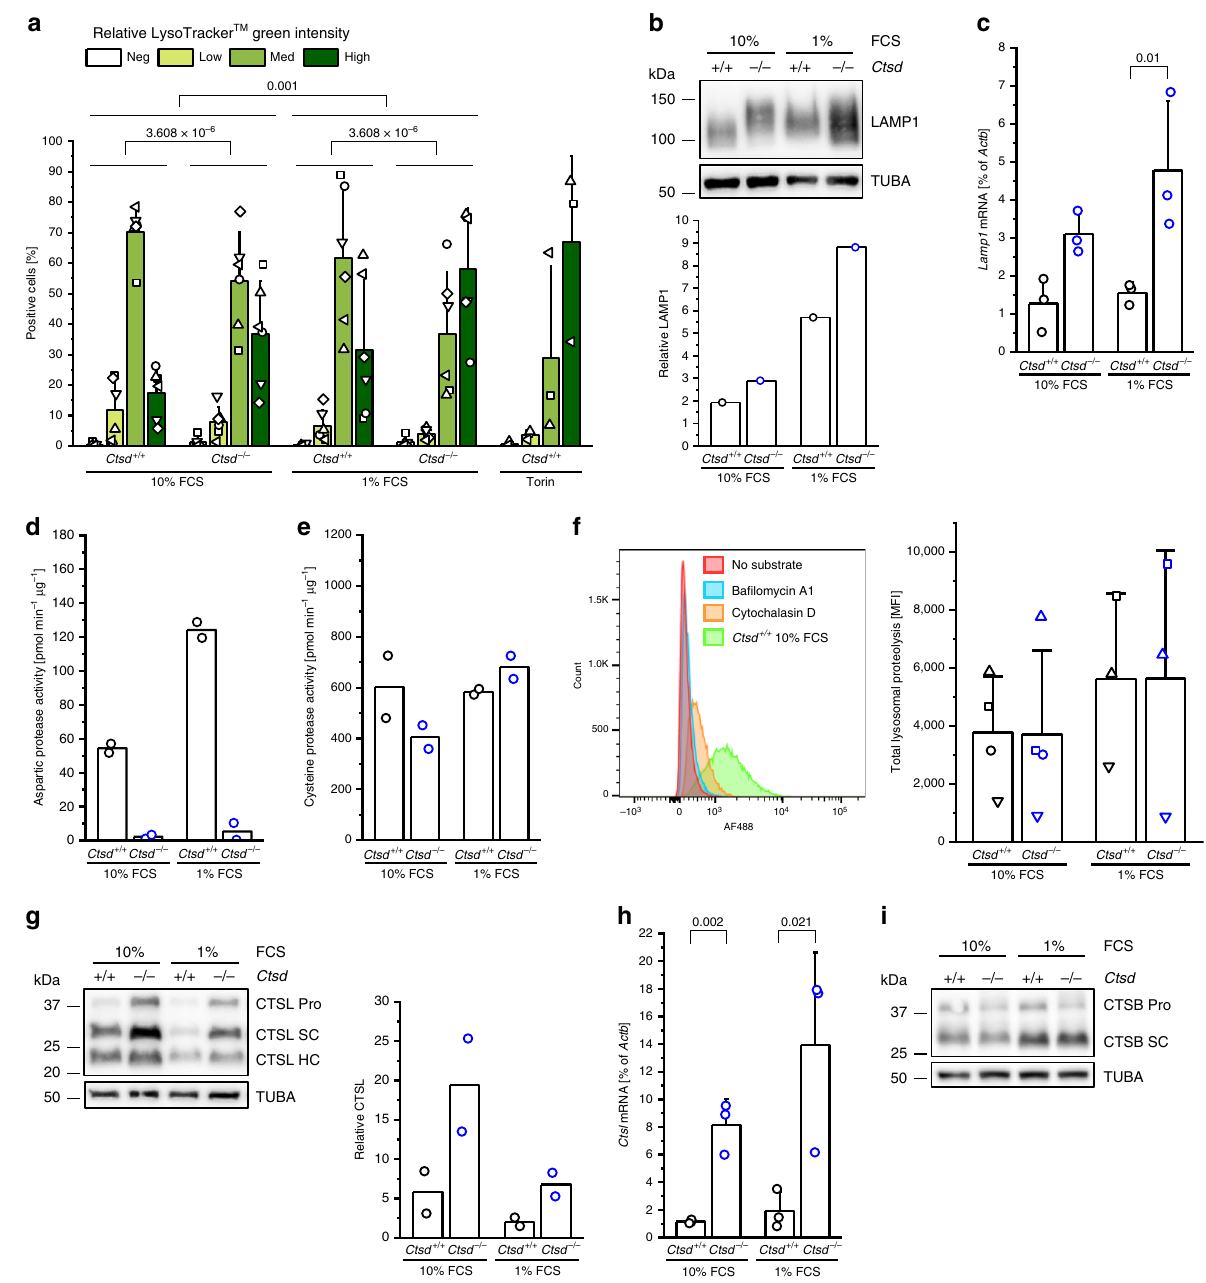
Fig. 4 CTSD de fi ciency expands the acidic cell compartment of short-term starved tumor cells. a Flow cytometry analysis of LysoTracker TM Green intensity in Ctsd + / + and Ctsd − / − PyMT cells cultured for 7 – 10 days in 10% FCS or 1% FCS medium or treated with Torin ( n = 3 independent experiments for Torin, n = 6 independent experiments for the rest; two-sided three-way ANOVA for the factors intensity of LysoTracker TM , Ctsd genotype and FCS). b Analysis of LAMP1 expression by Western blot (with TUBA as loading control) in 10% FCS and 1% FCS Ctsd + / + and Ctsd − / − PyMT cells. Slight molecular weight changes due to different glycosylation pattern. Representative of 2 independent experiments. Quanti fi cation is below ( n = 1 experiment). c Relative Lamp1 expression determined by RT-PCR in 10% FCS and 1% FCS Ctsd + / + and Ctsd − / − PyMT cells ( n = 3 independent experiments; two-sided two-sample t -test). Activity assay with substrates speci fi c for aspartic ( d ) or cysteine ( e ) proteases in 10% FCS and 1% FCS Ctsd + / + and Ctsd − / − PyMT cells ( n = 2 independent experiments). f Lysosomal activity assay using a quenched fl uorogenic substrate in 10% FCS and 1% FCS Ctsd + / + and Ctsd − / − PyMT cells ( n = 4 independent experiments for 10% FCS, n = 3 independent experiments for 1% FCS). Histogram including controls blocking the endocytic substrate uptake (Cytochalasin D) or lysosomal acidi fi cation (Ba fi lomycin A1) on the left, median fl uorescence intensity (MFI) on the right. g Analysis of CTSL expression by Western blot (with TUBA as loading control) in 10% FCS and 1% FCS Ctsd + / + and Ctsd -/- PyMT cells. Pro, zymogen; SC, single-chain form; HC, heavy chain. Representative of 2 independent experiments. Quanti fi cation is to the right ( n = 2 independent experiments). h Relative Ctsl expression determined by RT-PCR in 10% FCS and 1% FCS Ctsd + / + and Ctsd − / − PyMT cells ( n = 3 independent experiments; two-sided two-sample t - test). i Analysis of CTSB expression by Western blot (with TUBA as loading control) in 10% FCS and 1% FCS Ctsd + / + and Ctsd − / − PyMT cells. Pro, zymogen; SC, single-chain form. Representative of 2 independent experiments. Bar charts show all data points with mean + SD and p -value. Source data are provided as a Source Data fi